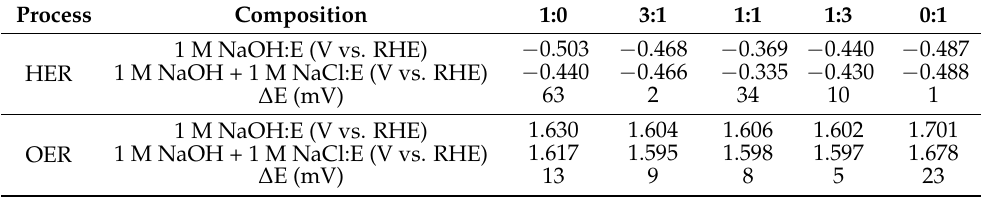
Table 1. Required potential to reach |j| = 10 mA cm − 2 during HER and OER for PANI-Ni:PANI-Co ratios of 1:0, 3:1, 1:1, 1:3, and 0:1 based on atomic ratio of Ni:Co after